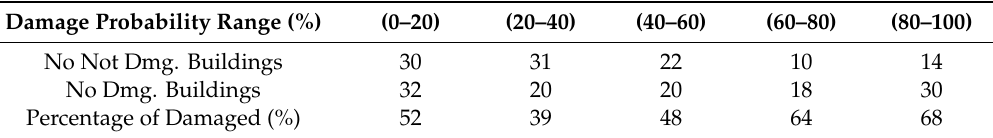
Table 3. Validation results of the damage probability